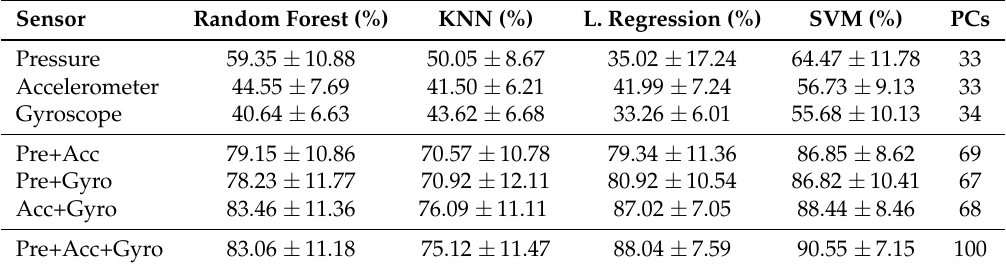
Table 5. Recall of the gait pattern classification using the variance combinations of the smart shoes sensor features based on the optimal number of principal components (PCs). Pre, Acc and Gyro denote pressure sensor, accelerometer and gyroscope, respectively.